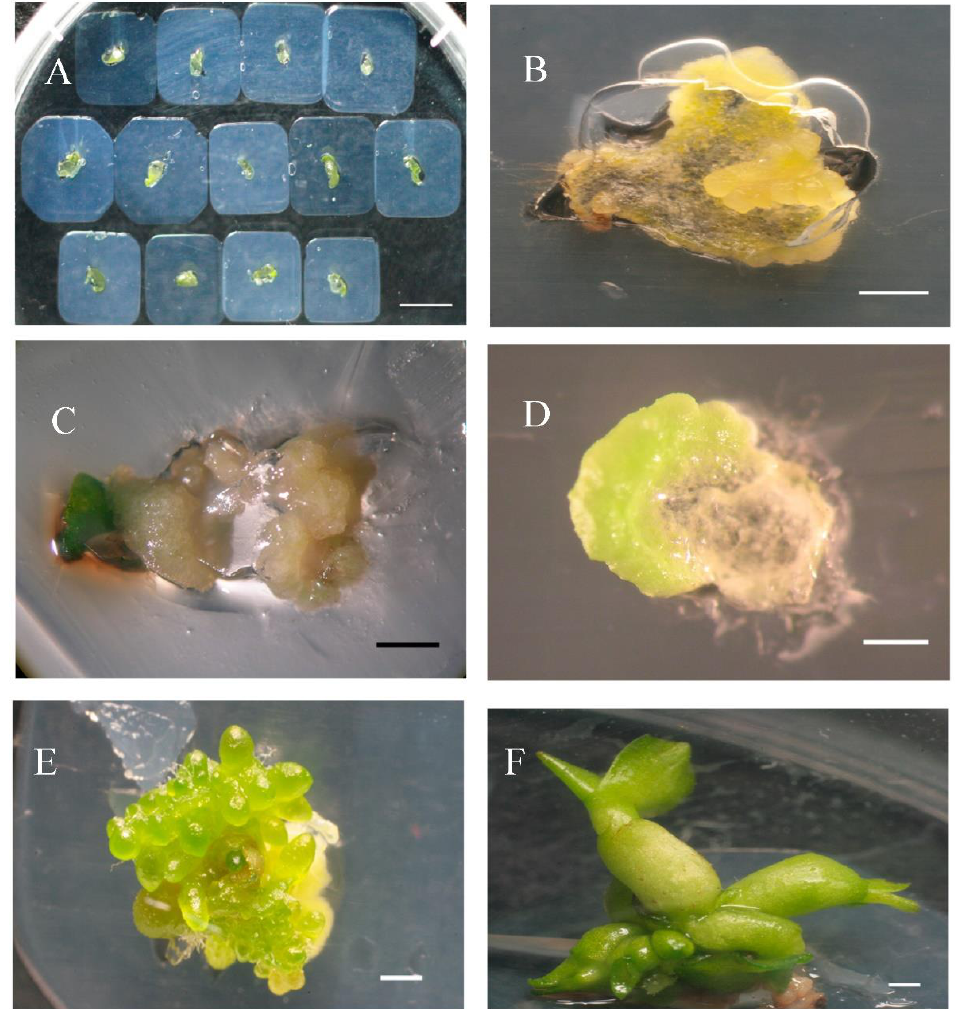
Figure 4. Two types of regeneration patterns from tTCL sections. ( A ) Serial arrangement of agarose tTCL sections generated by microtome slicing of PLB at 200μm (bar = 0.1 cm); ( B ) PLB neoformation in various development stages around the surface ring of the embedded tTCL (bar = 0.1 cm); ( C ) pale granular calli from the surface ring of the embedded tTCL (bar = 0.1 cm); ( D ) multiple cells occurring from the tTCL surface, which then developed into shoots (bar = 0.1 cm); ( E ) multiple PLBs regenerated from the outer surface of tTCL (bar = 0.5 cm); ( F ) after culturing for 90 days, the development of multiple shoots could be observed (bar = 0.1 cm).